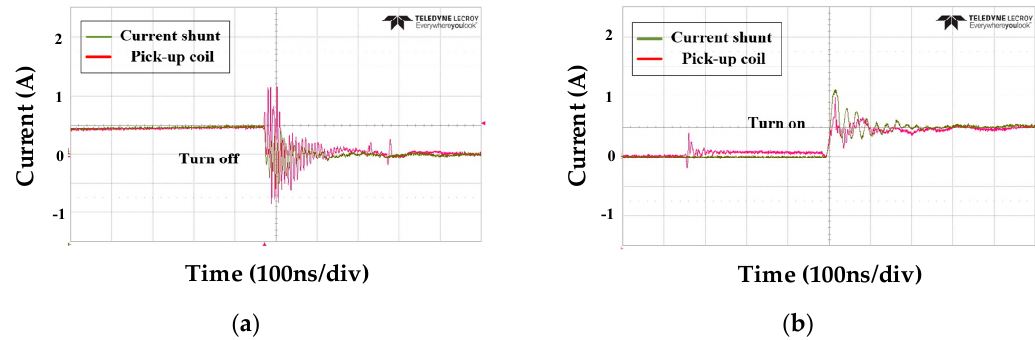
Figure 13. Measured pick-up coil sensor output following switch behavior when the DC link voltage is 100 V: ( a ) switch turn-off; ( b ) switch turn-on.